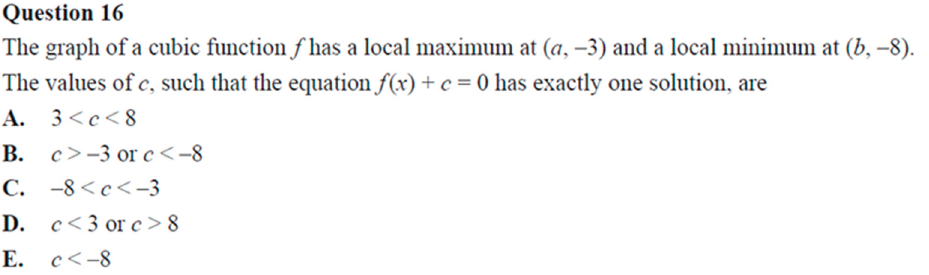
Figure 4. The 2012 Mathematical Methods Examination 2, multiple-choice Question 16 (© VCAA 2012; by permission). 2012; by